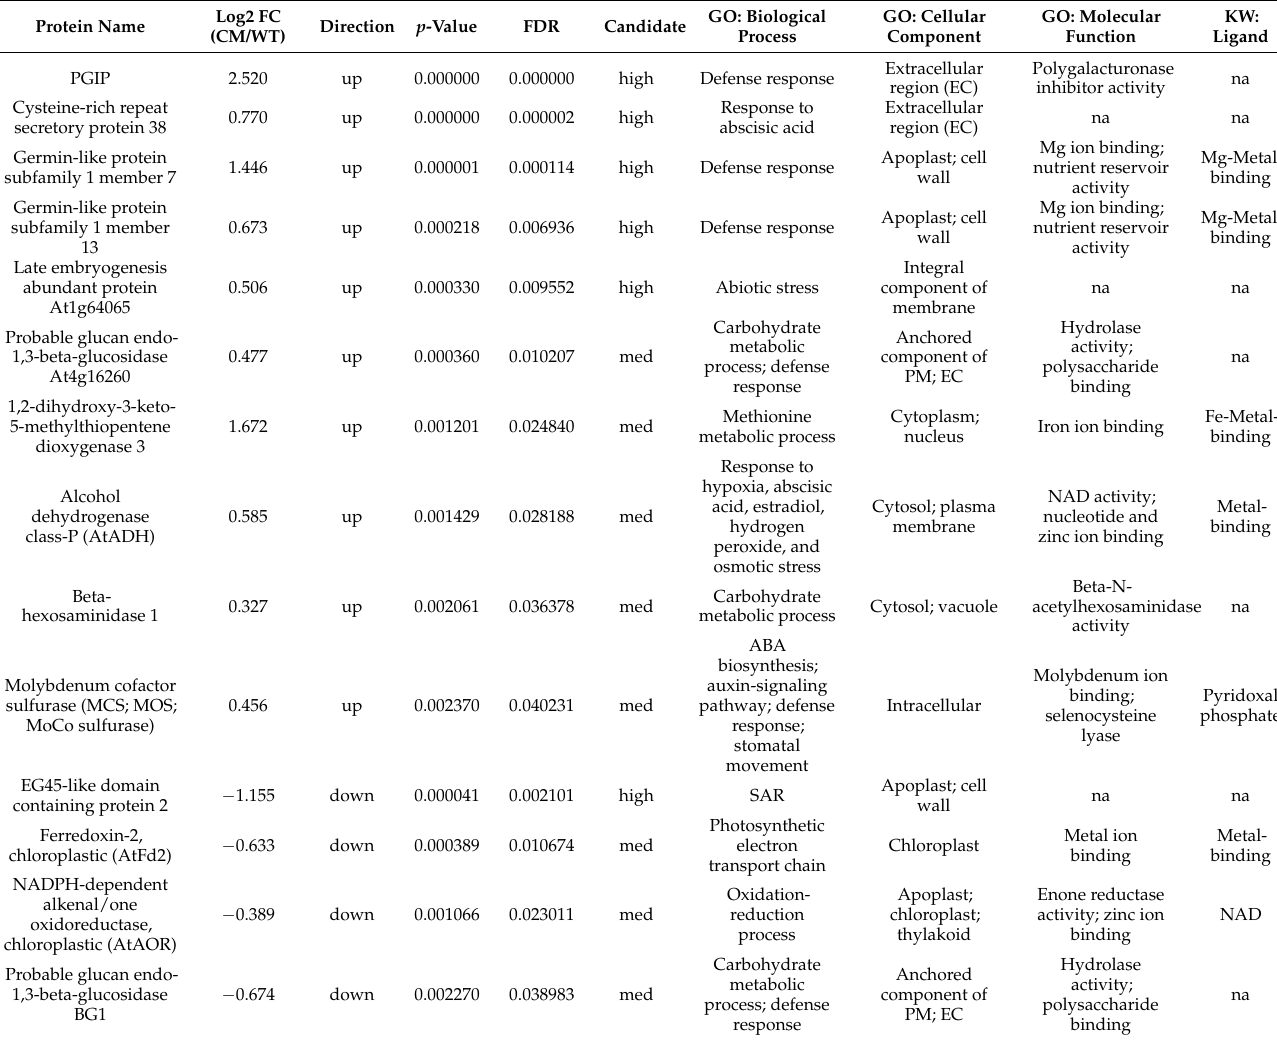
Table 3. Differentially abundant proteins in Jr with FDR ≤